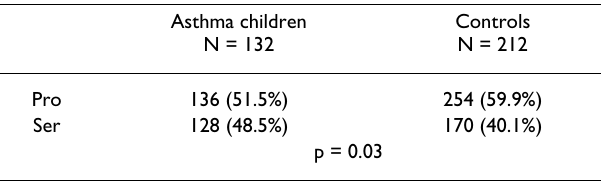
Table 3: Allele frequencies of the TLR6 Ser249Pro polymorphism in asthma children vs .